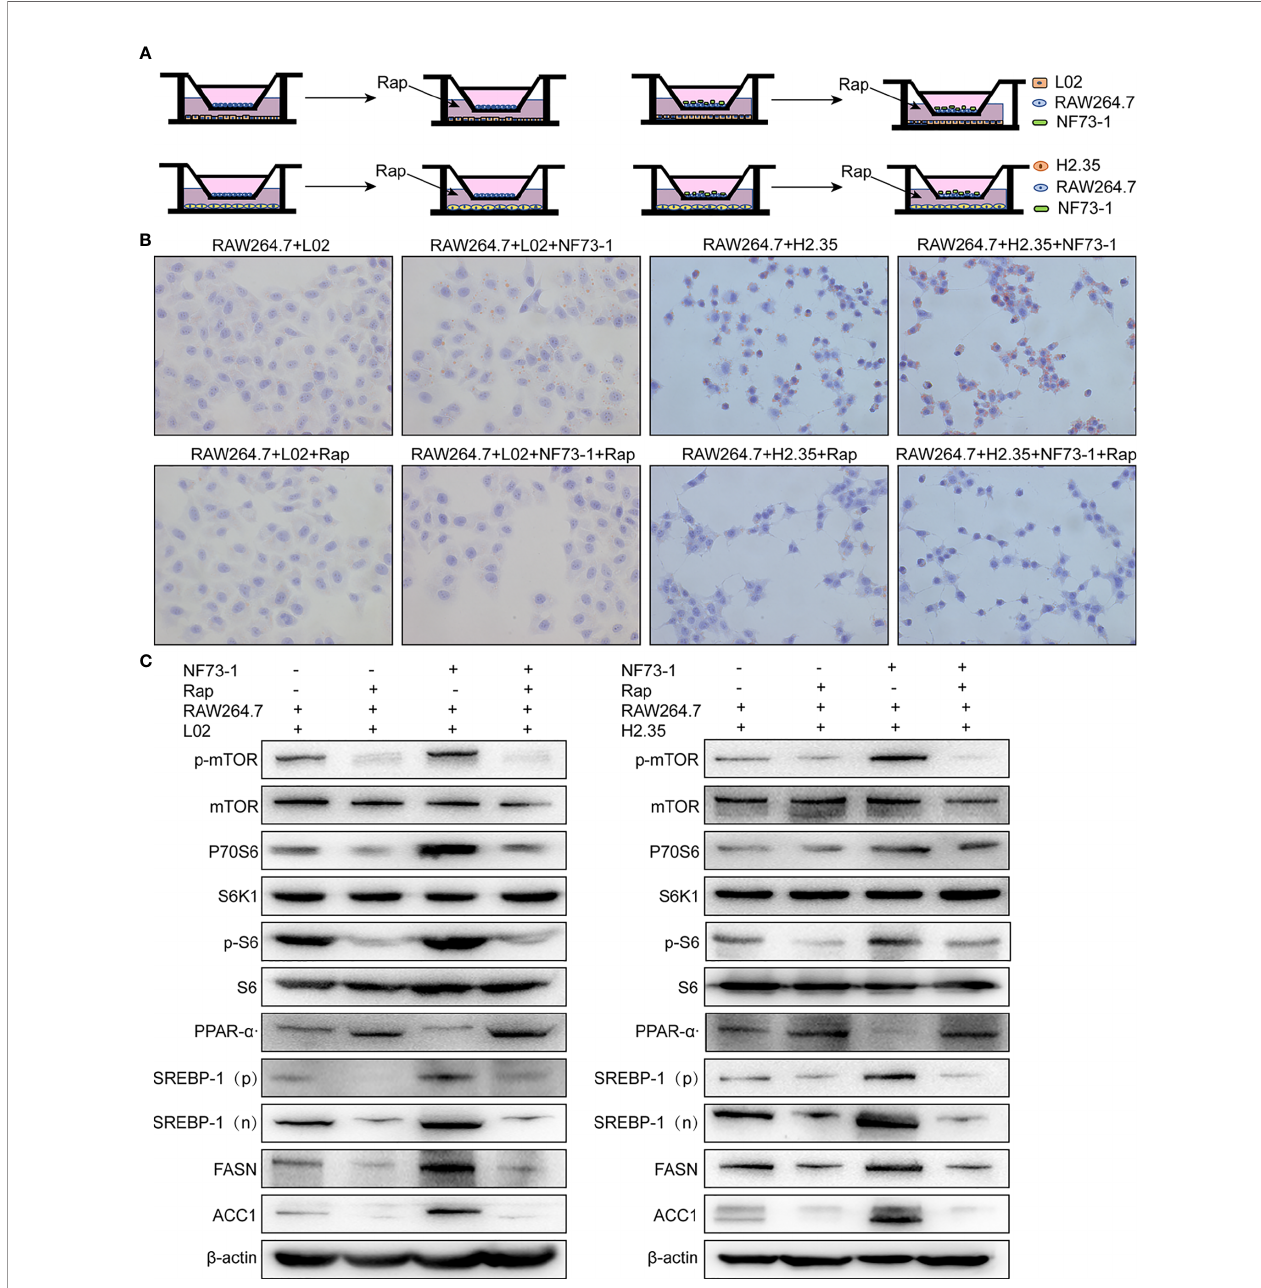
FIGURE 8 | E. coli NF73-1, the inducer of M1 polarization and hepatocyte steatohepatitis in vitro. (A) Schematic illustration of L02 and H2.35 hepatocytes with RAW264.7, in the presence or absence E. coli NF73-1 and rapamycin with palmitic acid- and oleic acid-containing medium. (B) Lipid accumulation detected by Oil Red O staining in hepatocytes cocultured with RAW264.7 in the presence or absence E. coli NF73-1 and rapamycin with palmitic acid- and oleic acid-containing medium. (C) Protein synthesis of phosphorylated mTOR, S6K1, S6, SREBP-1, ACC1, FASN, and PPAR- a in palmitic acid- and oleic acid-treated hepatocytes cocultured with or without E. coli NF73-1 and rapamycin. mTOR, mammalian target of rapamycin; S6K1, S6 kinase 1; SREBP-1, sterol-regulatory element binding protein-1; ACC1, acetyl-coenzyme A carboxylase; FASN, fatty acid synthase; PPAR- a , peroxisome proliferator-activated receptor alpha; N, cleaved nuclear (68 kDa) form of SREBP-1; P, precursor (125 kDa) form of